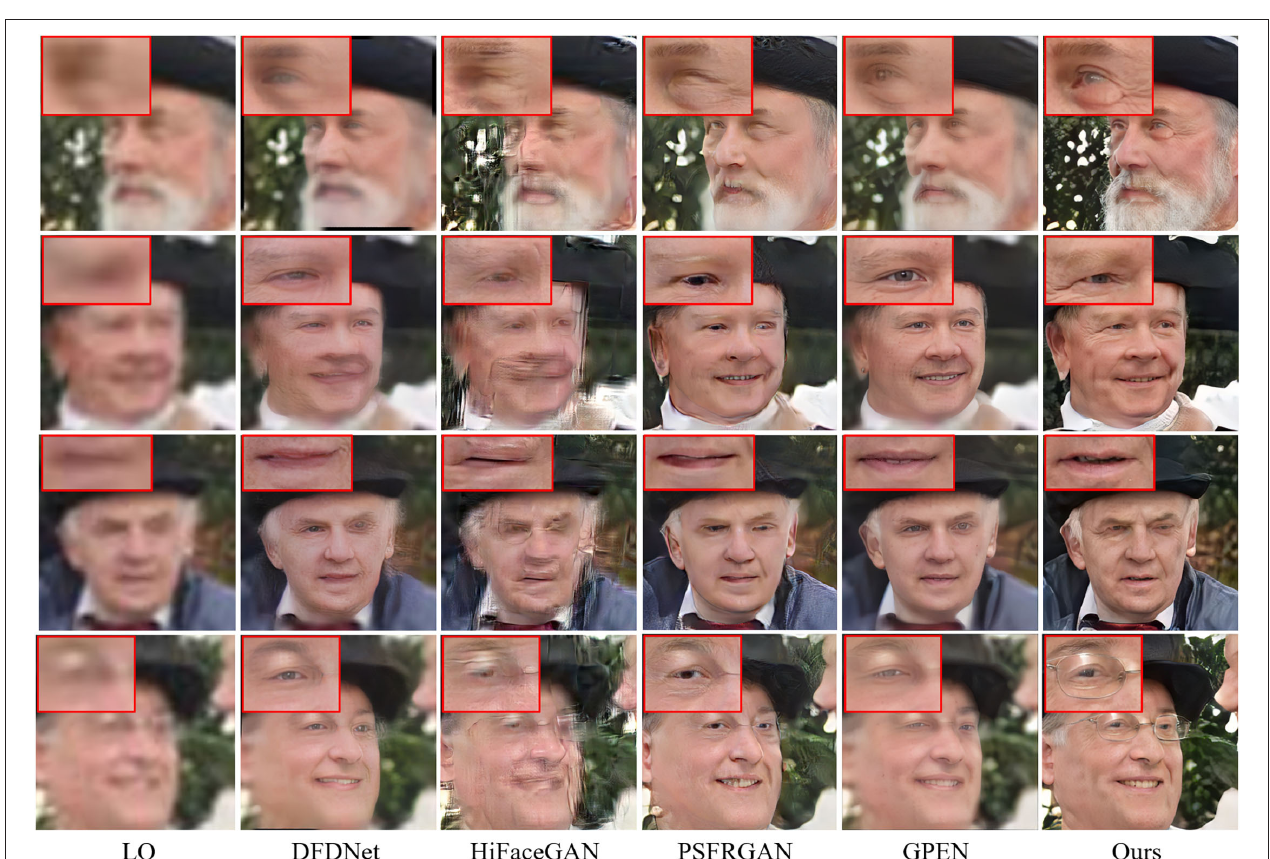
FIGURE 14 | Visual comparisons of competing methods with top performance on real-world low-quality (LQ) images (